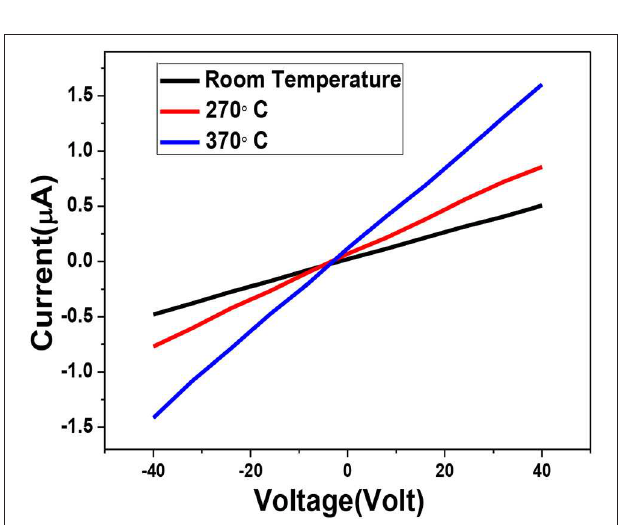
FIGURE 8 | Temperature vs. response (%) plot for α -MoO 3 nanoparticles for 100 ppm ethanol. check the semiconductor-metal contact of the sensor element.